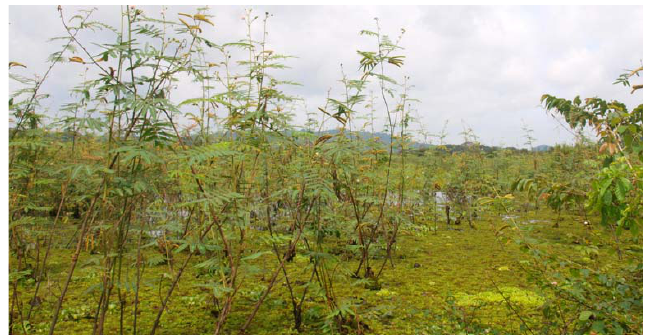
Figure 2. Mimosa pigra infesting Tram Chim National Park